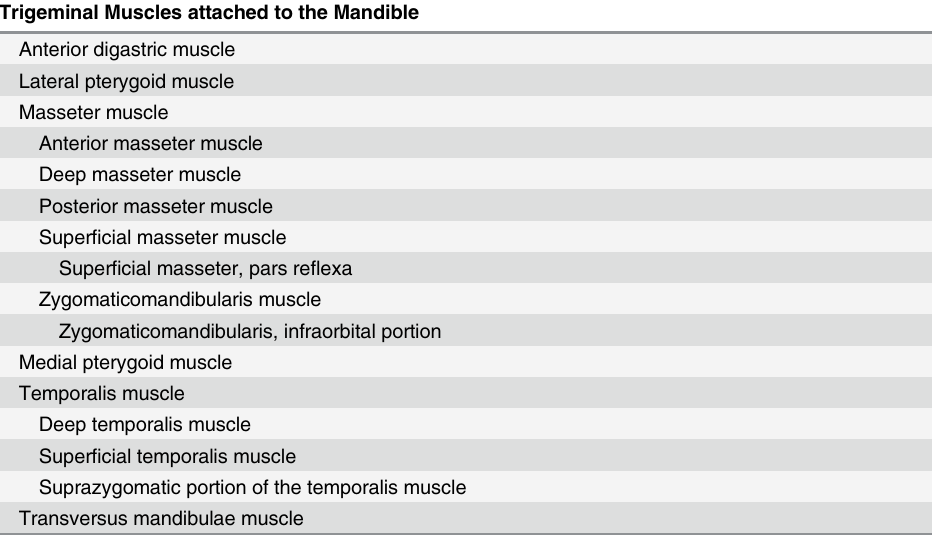
Table 3. Classes returned from a DL Query for muscles innervated by the trigeminal nerve that are attached to the mandible. Trigeminal Muscles attached to the